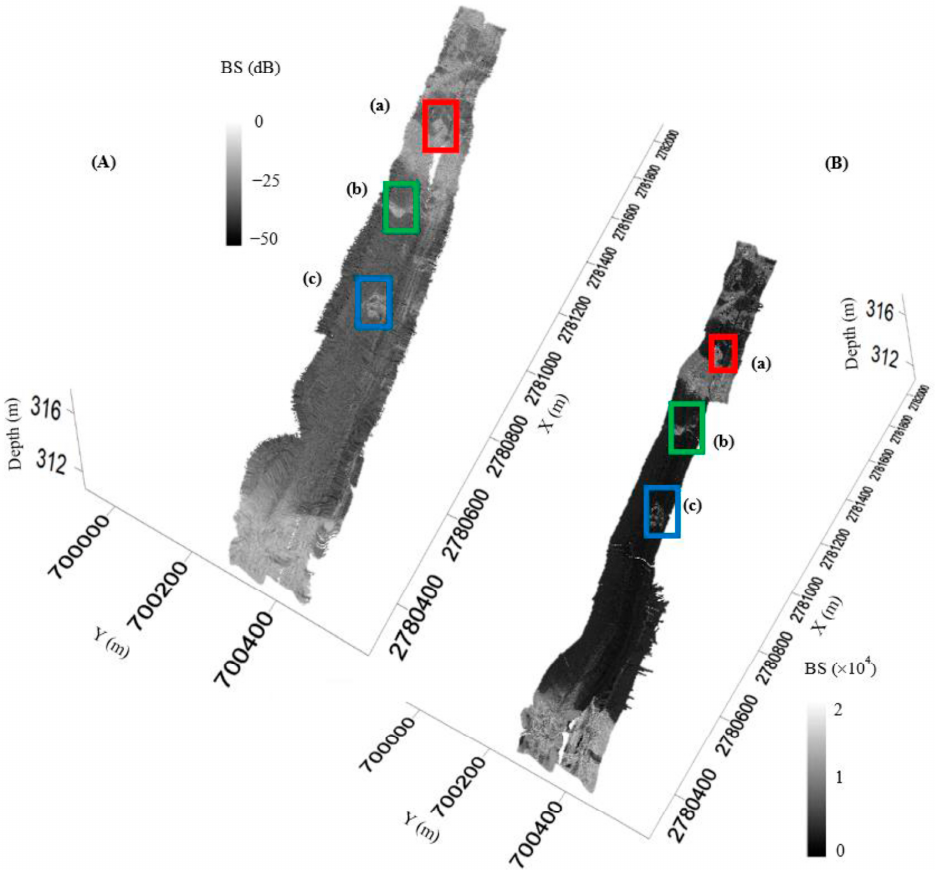
Figure 12 . Superimposition of the MBES snippet image and terrain ( A ) and that of the corrected positional SSS image and MBES terrain ( B ) in entire waters. ( a – c ) denote three small areas at different locations of the measurement area.